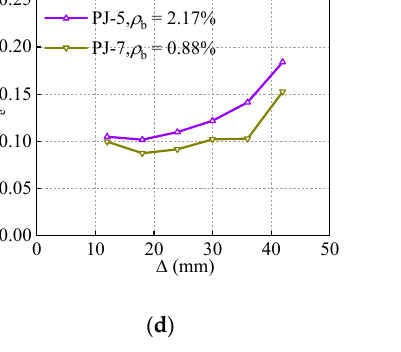
Figure 13. Effects of design parameters on the equivalent viscous damping ratio. ( a ) Steel ratio of STC. ( b ) Stirrup ratio of the joint. ( c ) Axial compression ratio. ( d ) Reinforcement ratio of the frame beam. ( e ) CFRP strips spacing.